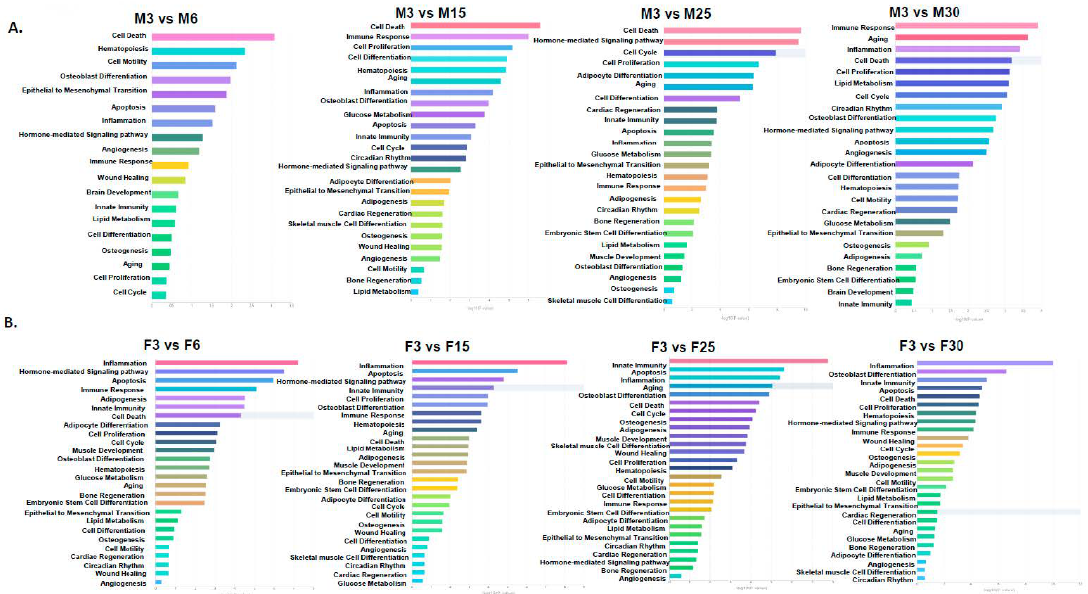
Figure 2. Functional enrichment analysis of the di ff erentially expressed adipomiRs: TAM 2.0 was used to determine microRNA (miRNA)-functional enrichment analysis of adipomiRs that were di ff erentially expressed in each group compared to the 3 mo rat ( A ) Male and ( B ) Female rats. The functions are listed according to the highest to the lowest association with the di ff erentially expressed adipomiRs.